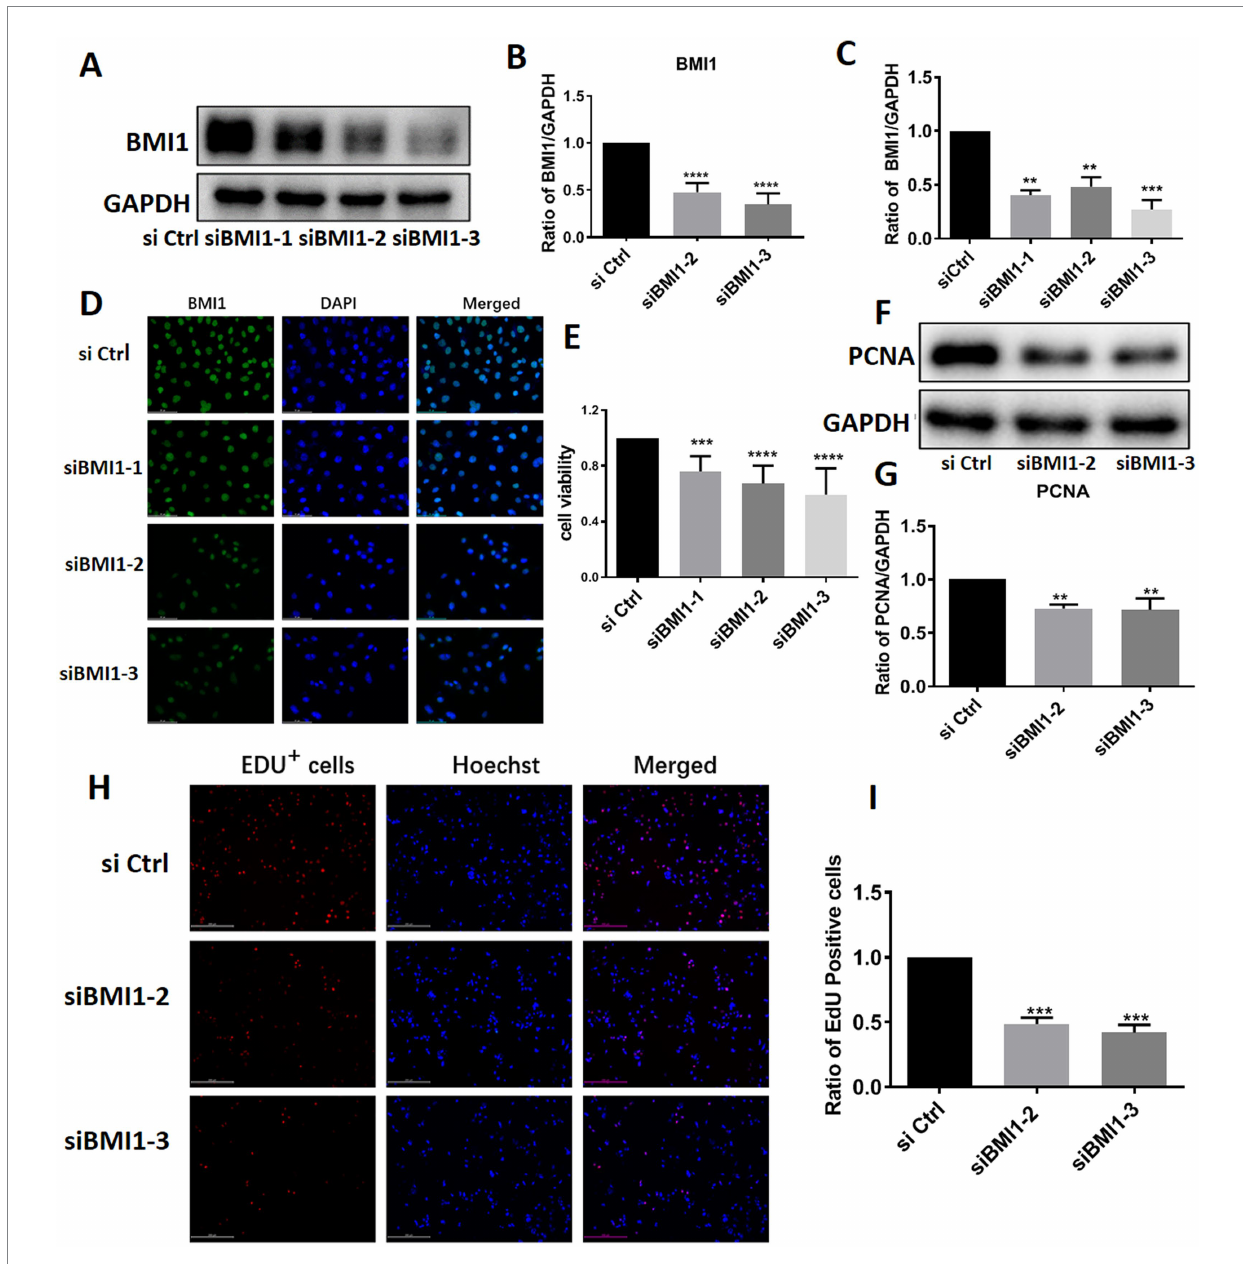
FIGURE 2 BMI1 silencing suppressed the proliferation and DNA synthesis of mouse